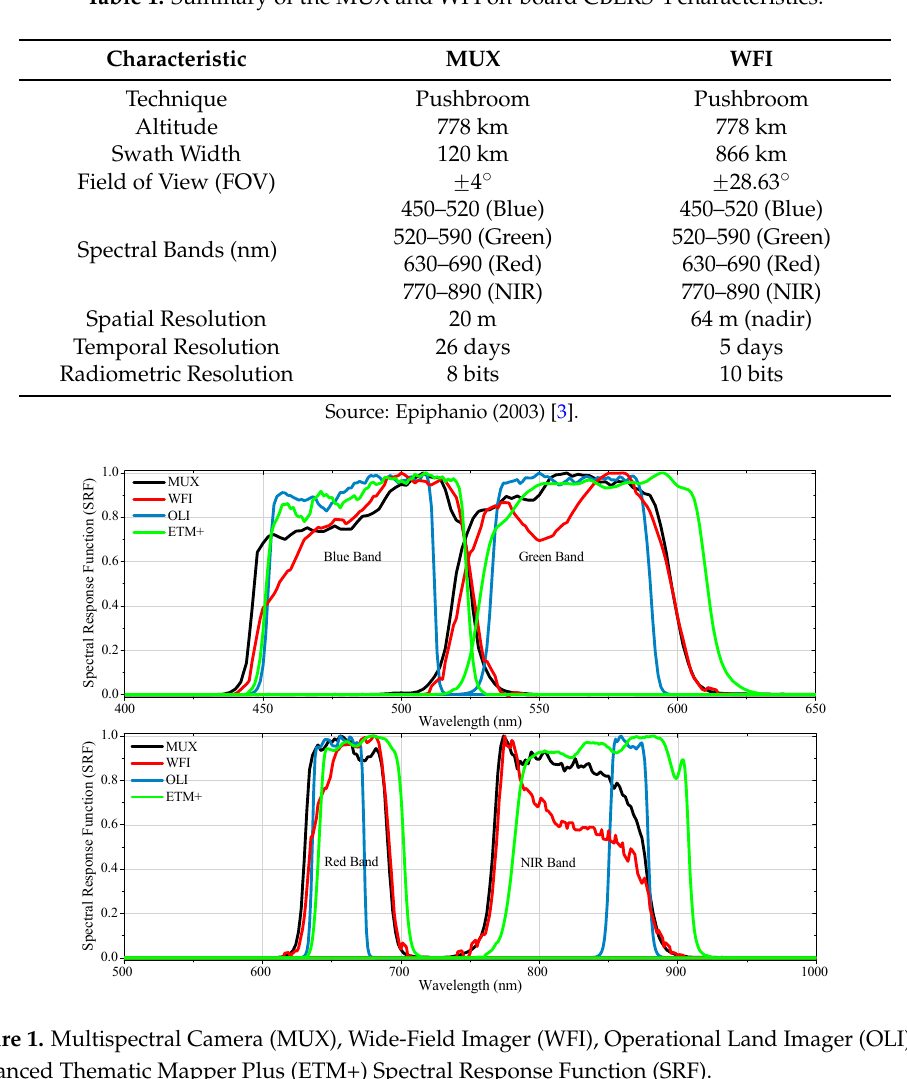
Table 1. Summary of the MUX and WFI on-board CBERS-4 characteristics.